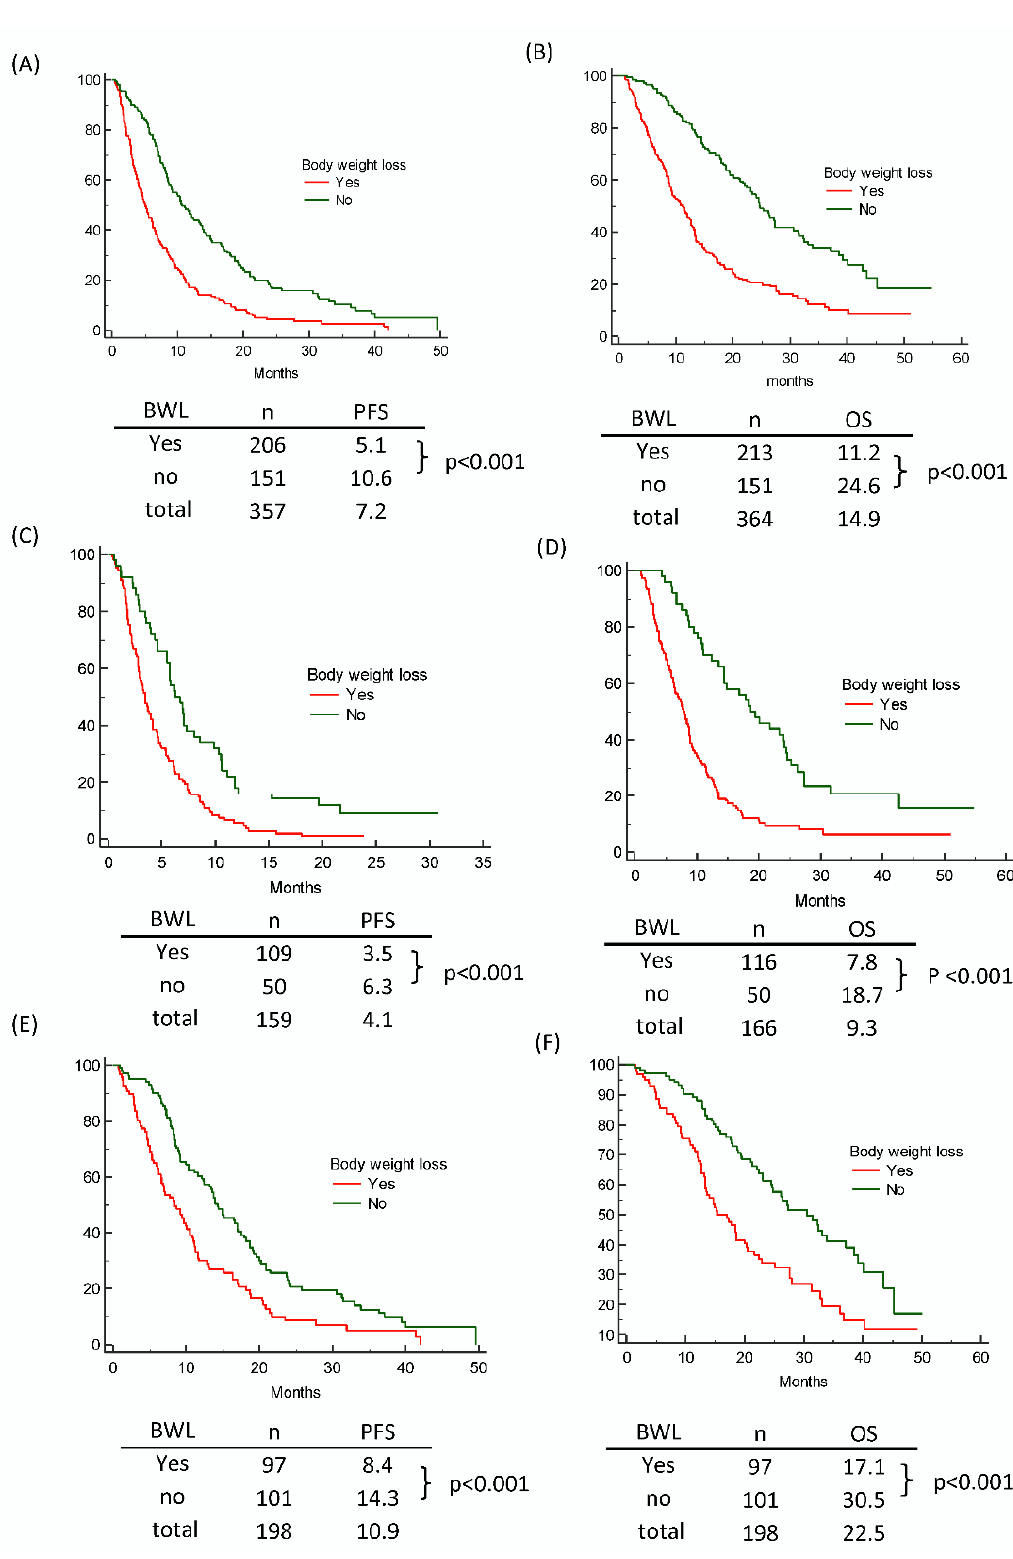
Figure 5. Influence of the body weight loss on ( A ) PFS and ( B ) OS of all NSCLC patients; ( C ) PFS, and ( D ) OS of NSCLC patients with wild-type EGFR status; ( E ) PFS and ( F ) OS of NSCLC patients with EGFR mutation. BMI—body mass index; PFS—progression-free survival; OS—overall survival; NSCLC—non-small cell lung cancer; EGFR—epidermal growth factor receptor.